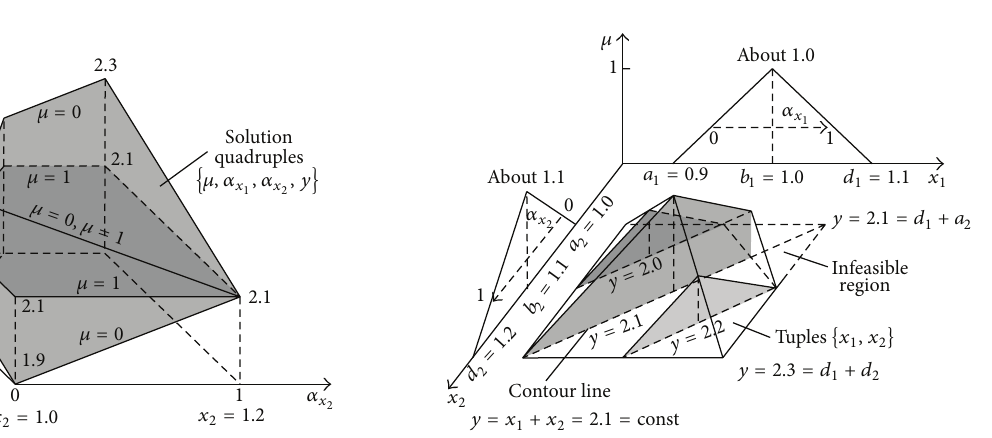
Figure 13: 3D projection of the 4D granule of the addition result of two fuzzy numbers “about 1.0” and “about 1.1” onto the space 𝑋 1 × × 𝑌 . 𝑋 2